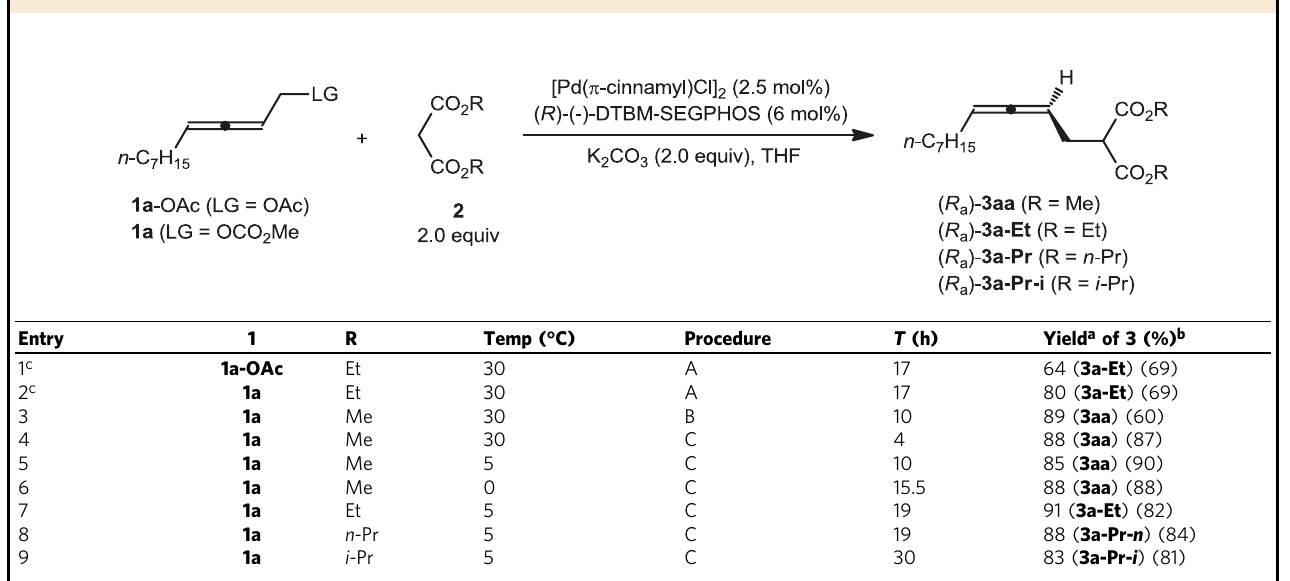
Table 1 The optimization of reaction parameters